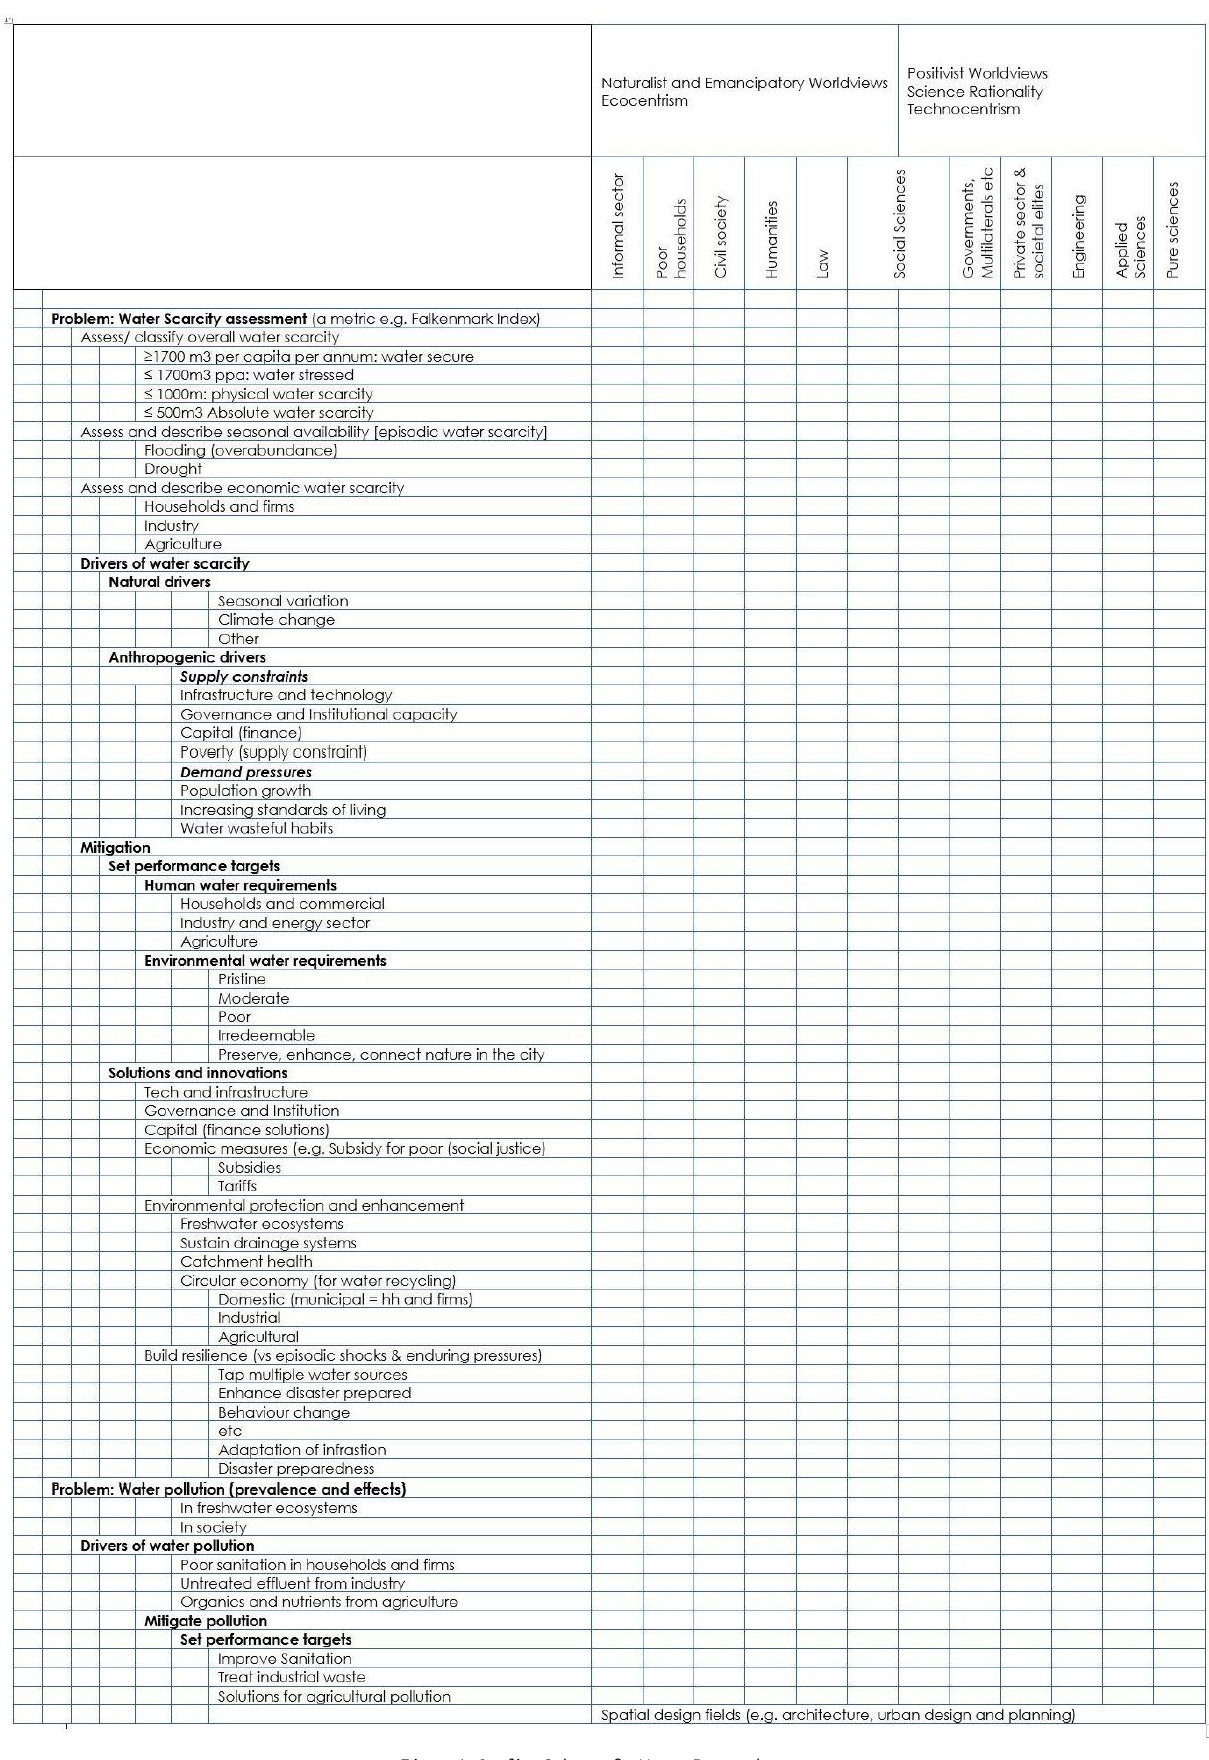
Figure 1: Outline Schema for Water